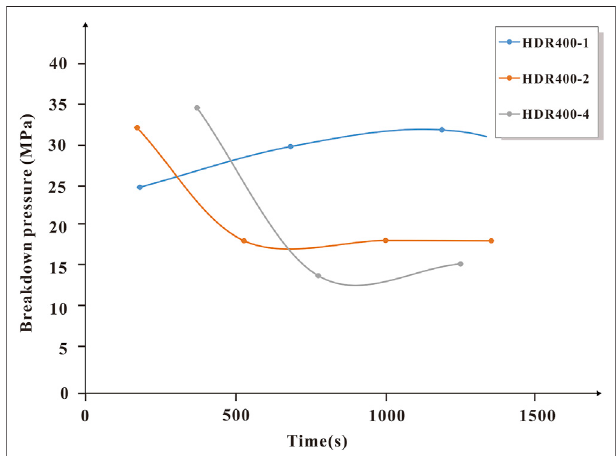
FIGURE 13 | Comparison of sample breakdown pressure curves over time.